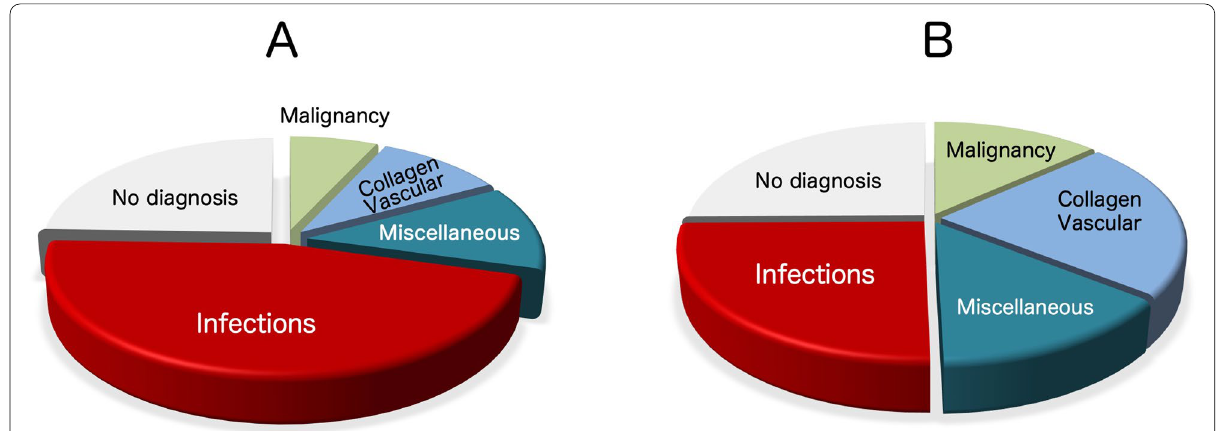
Fig. 1 Final etiologies for fever of unknown origin. Collective data from multiple references are shown to compare the frequencies of final diagnoses for fever of unknown origin. Children ( A ) and adults ( B ) show different